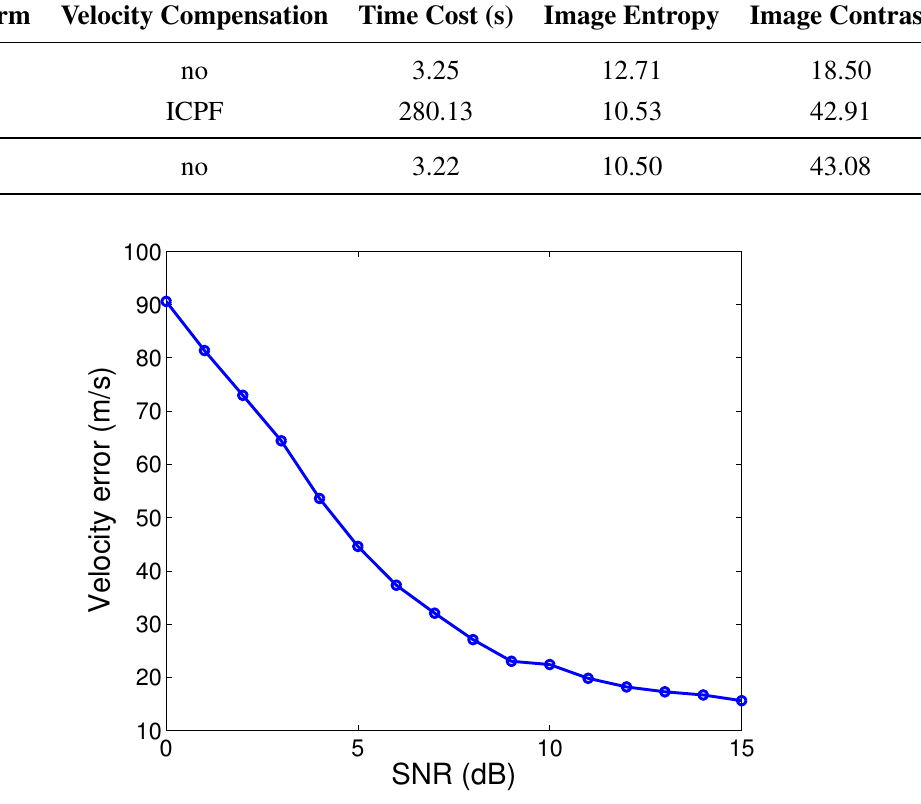
Figure 7. The estimated velocity errors with the ICPF method under different